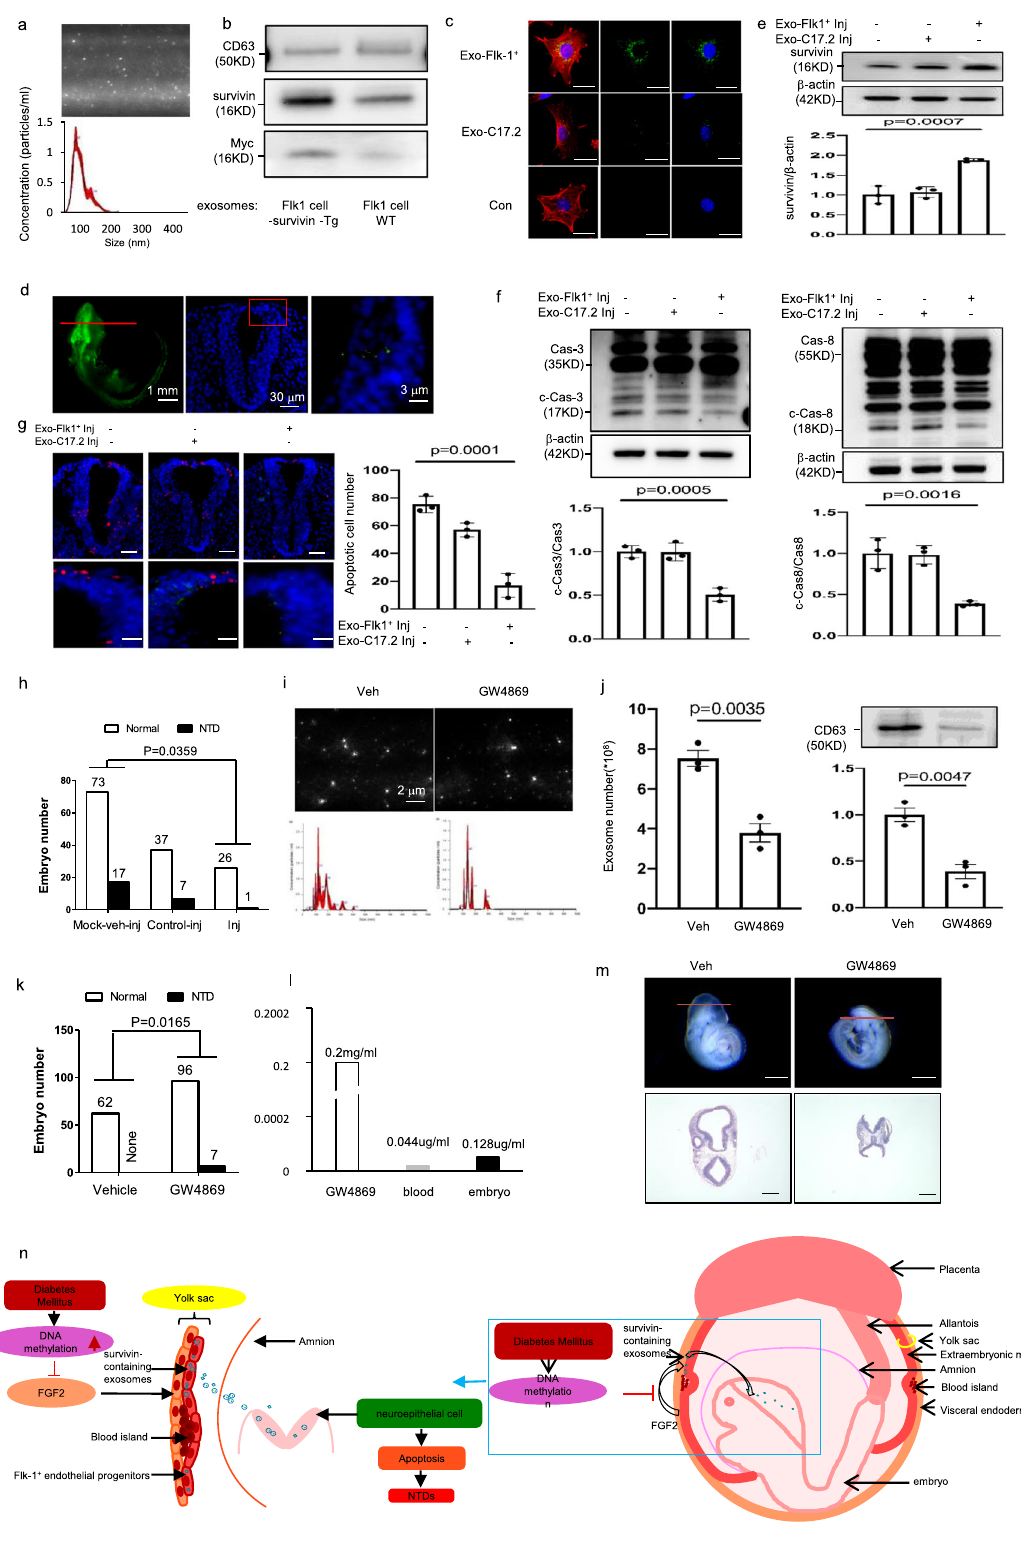
tissues or organs. Indeed, exosomes derived from Flk-1 + pro- genitors, which exclusively reside in the yolk sac in early embryonic development, cross the intra-ammonic space to target cells in the neuroepithelium, which is in the innermost layer of the embryo. This may explain why the Flk-1 + progenitor-speci fi c